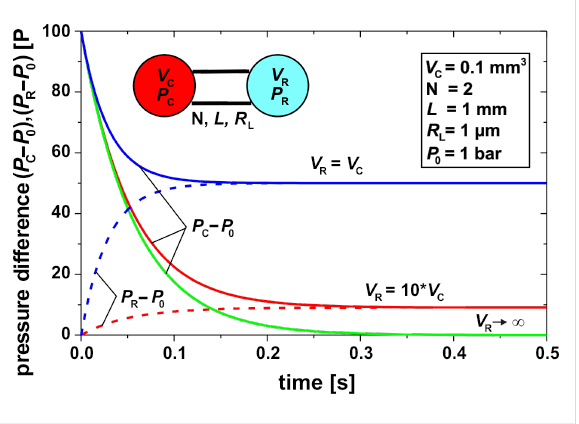
Figure 12: Pressures in the cavity, P C , and in the reservoir, P R , as a function of time for a cavity with a volume V C = 0.1 mm 3 connected by two compensation leaks to a reservoir volume V R for different values of V R / V C , P 0 : ambient pressure.